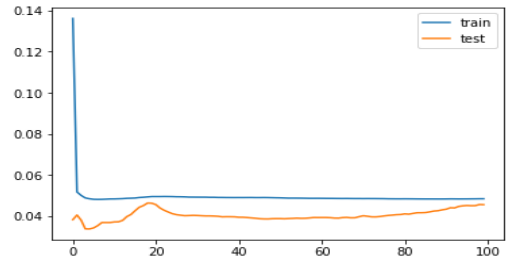
Figure 6 . Loss curve on training and test Data.